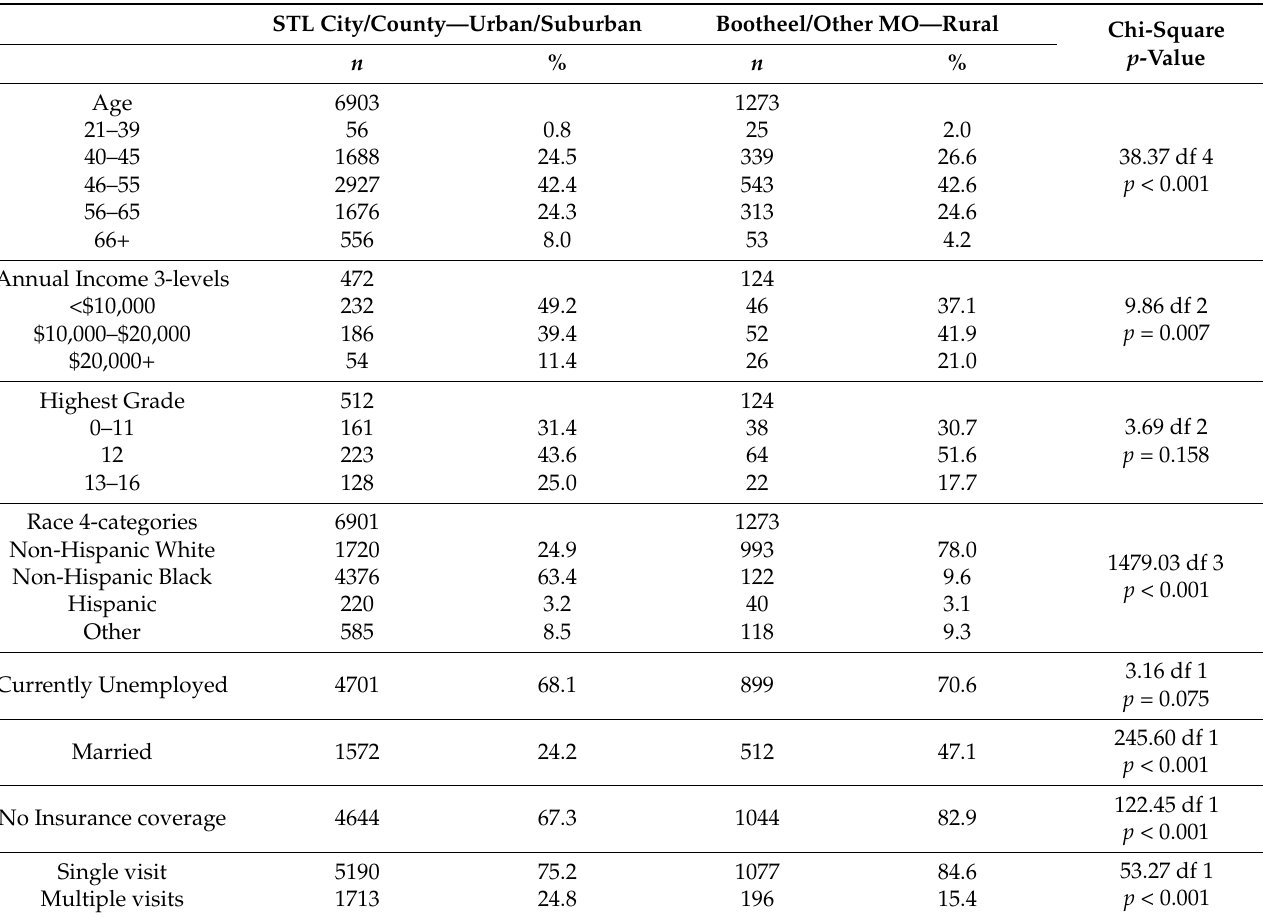
Table 3. Bivariate association between demographics and urban versus rural